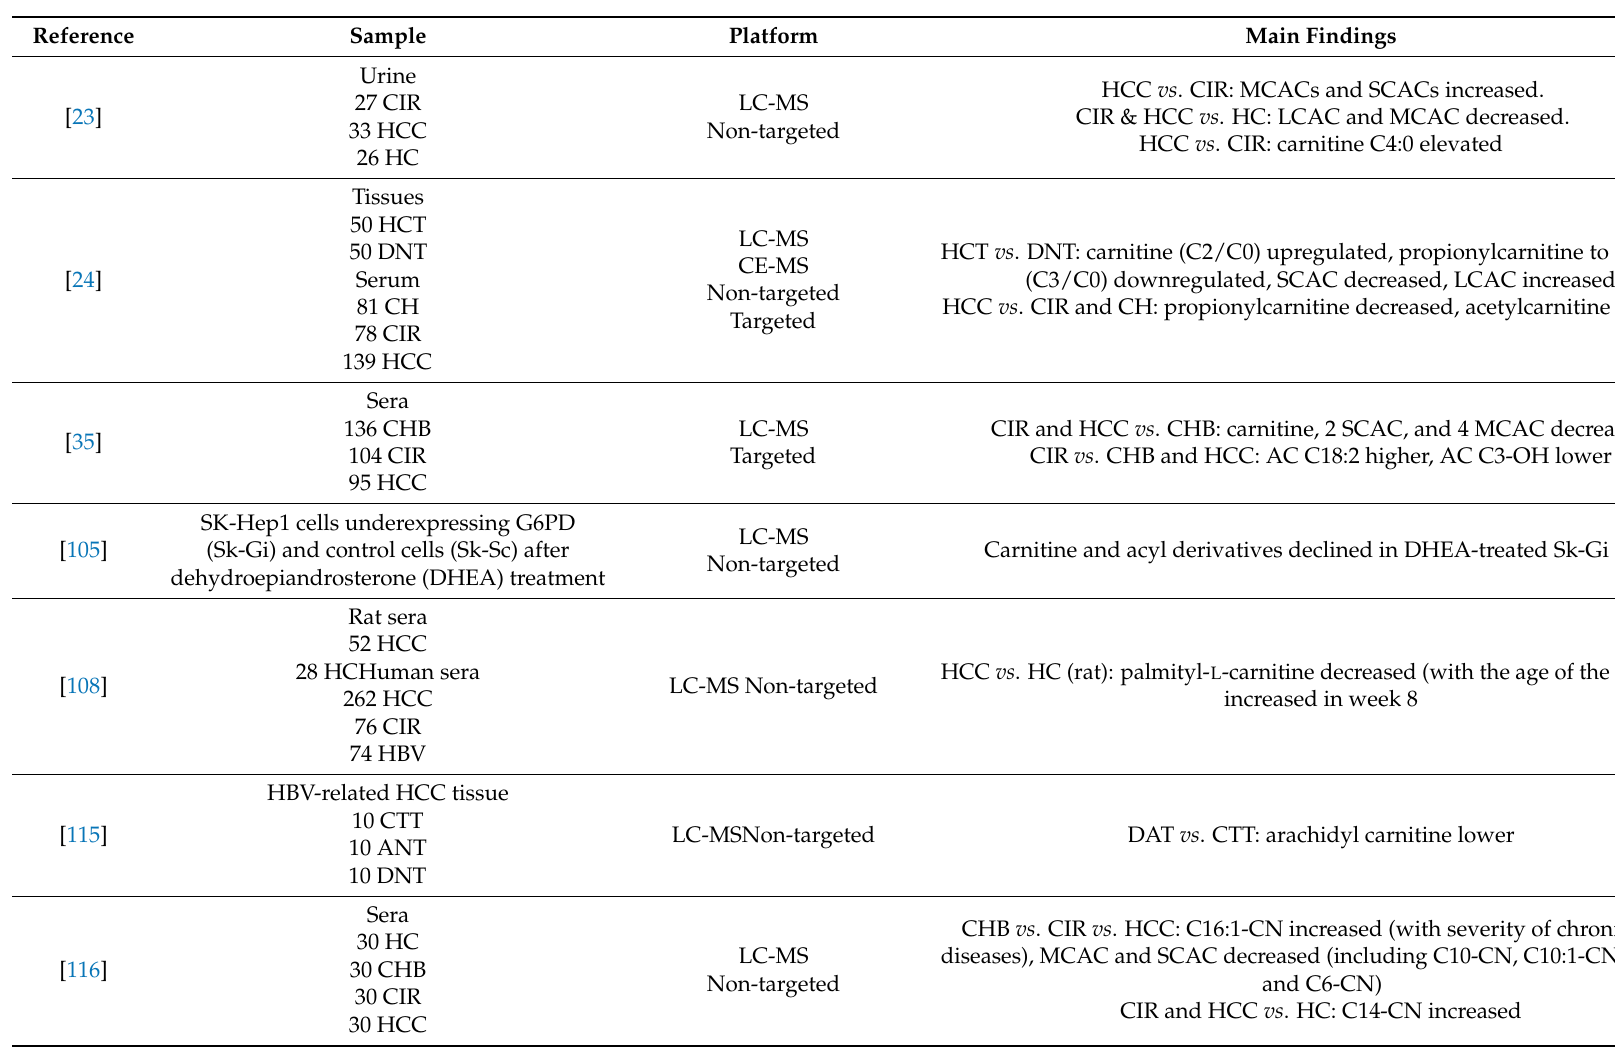
Table 1. Differential acylcarnitines between HCC and liver disease control